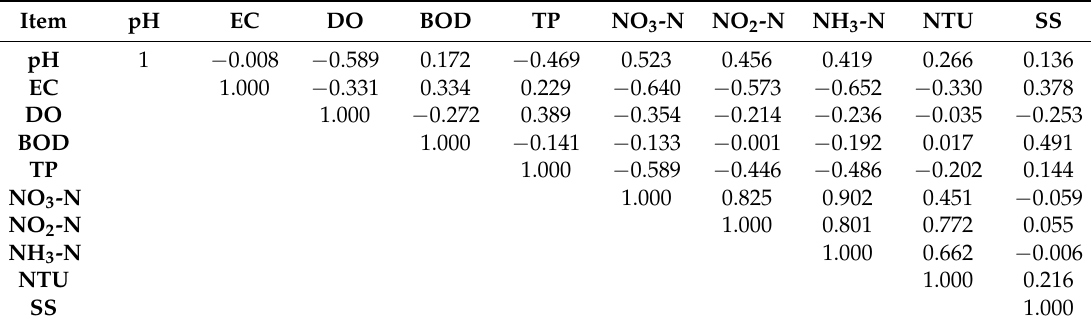
Table 1. Correlation coefficient matrix for each water quality